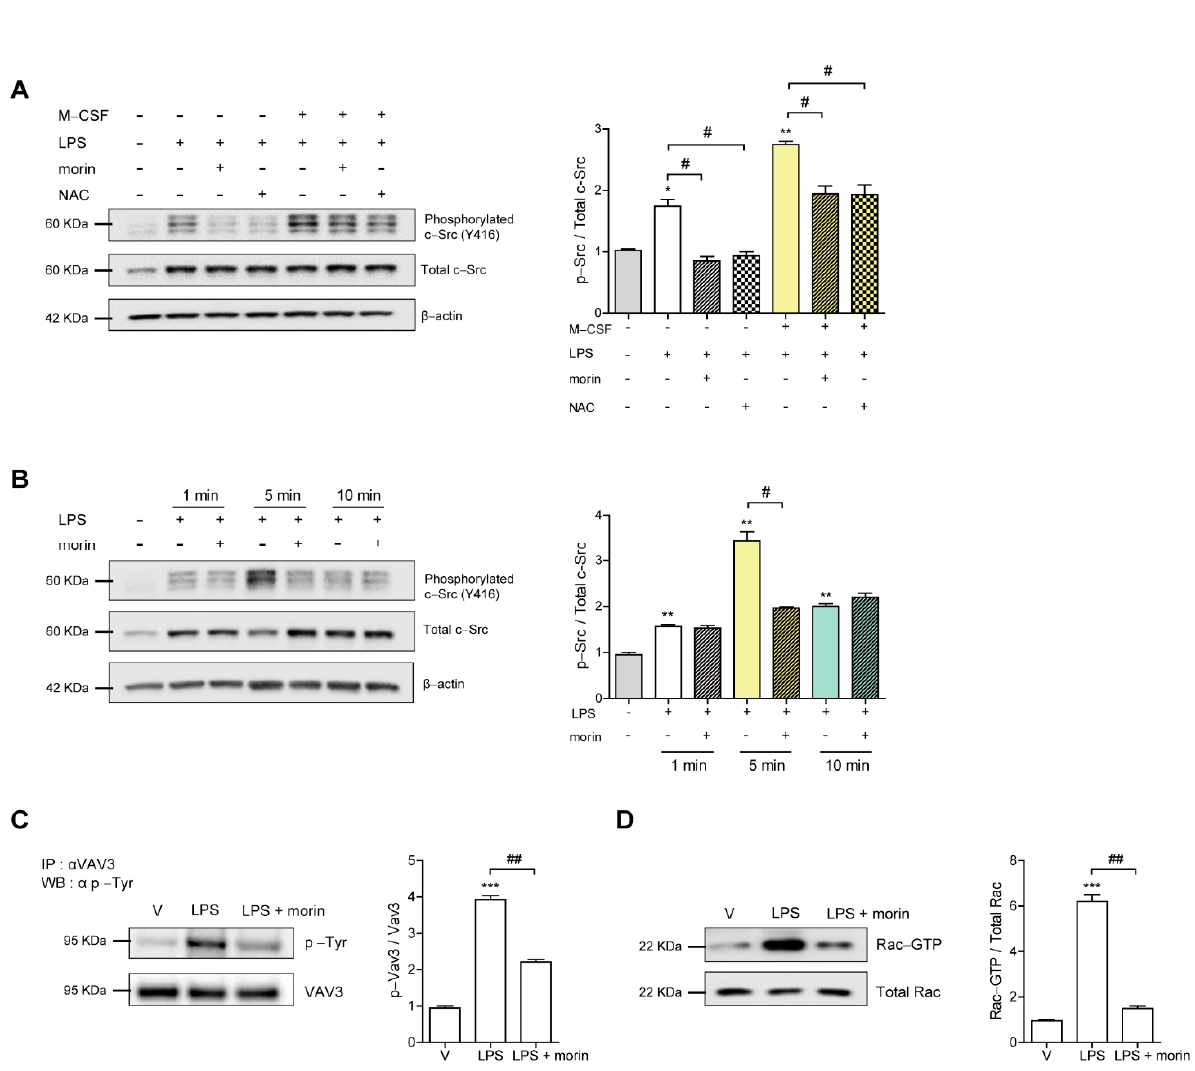
Figure 4. Morin decreases LPS-induced cytoskeletal reorganization via a signaling pathway involving c-Src/Vav3/Rac1in OCs. BMMs were cultured with M-CSF (30 ng/mL) and RANKL (40 ng/mL) for 96 h. Cells were washed with PBS and stimulated with LPS (50 ng/mL) ± morin (200 μ M) or NAC (3 mM) in the presence or absence of M-CSF (30 ng/mL) as indicated. As a control, BMM was loaded at the first lane. The cell lysate was immunoblotted for phosphorylated c-Src (Y416) after 5 min of exposure ( A ) or the indicated timepoints ( B ). The strong central band was calculated for phosphorylated c-Src. After 5 min of exposure, phosphorylation of Vav3 on tyrosine residue was detected by immunoprecipitation with anti-Vav3 and anti-phosphorylated Tyr ( C ). GST pulldown and immunoblotting with Rac-specific antibodies were used to assess GTP-Rac ( D ). * p < 0.05, ** p < 0.001, *** p < 0.001 compared with vehicle; # p < 0.05, ## p < 0.01 compared with LPS-treated cells. Similar results were obtained in three independent experiments.